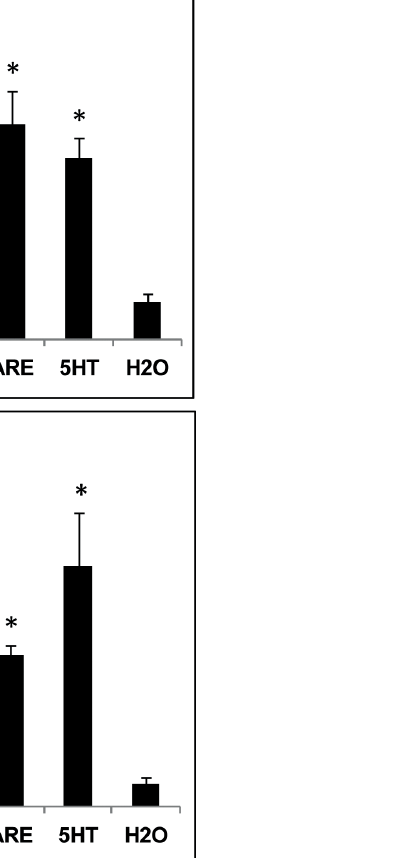
Figure 1. Effect of A. thaliana root exudates (ARE) on M. incognita stylet movements. A , Percentage of responsive nematodes and B , frequency of thrusting after 15 min of treatment with 20 m L of ARE (equivalent to 0.45 mg of dry weight of root) (ARE), 5 mM 5- hydroxytryptamine (5HT) or distilled water (H 2 O). Error bars indicate + / 2 SEM. Statistical significance (ANOVA) of pair-wise comparisons between treatments (ARE or 5HT) and the water control is indicated by asterisks (P ,